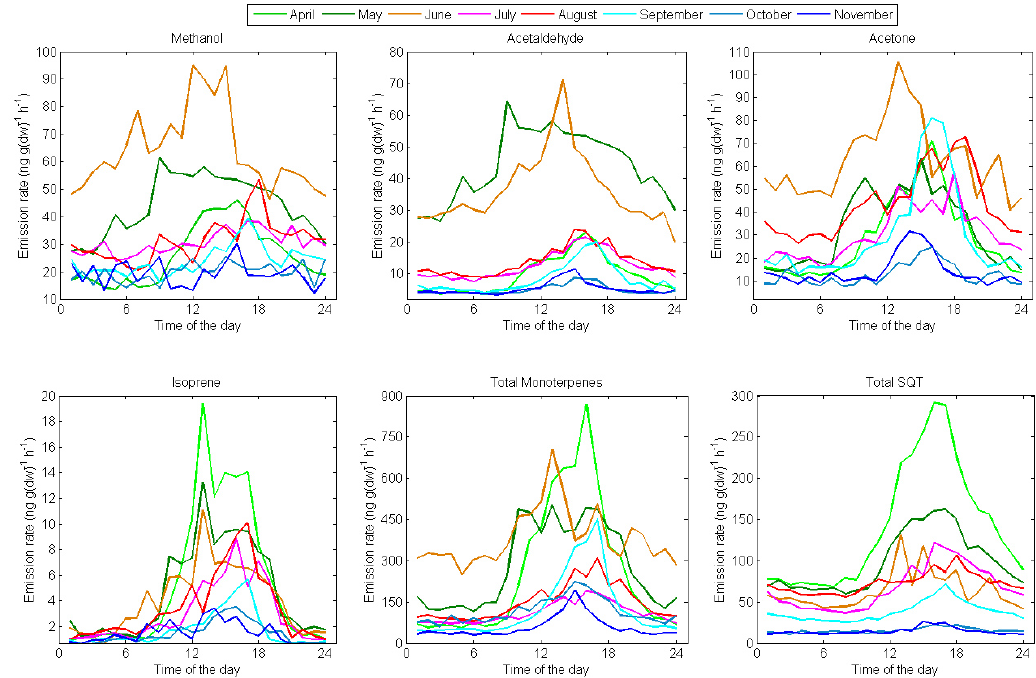
Figure 5. Diurnal patterns for the most abundant emissions from Norway spruce, including both oxVOC (top) and isoprenoids